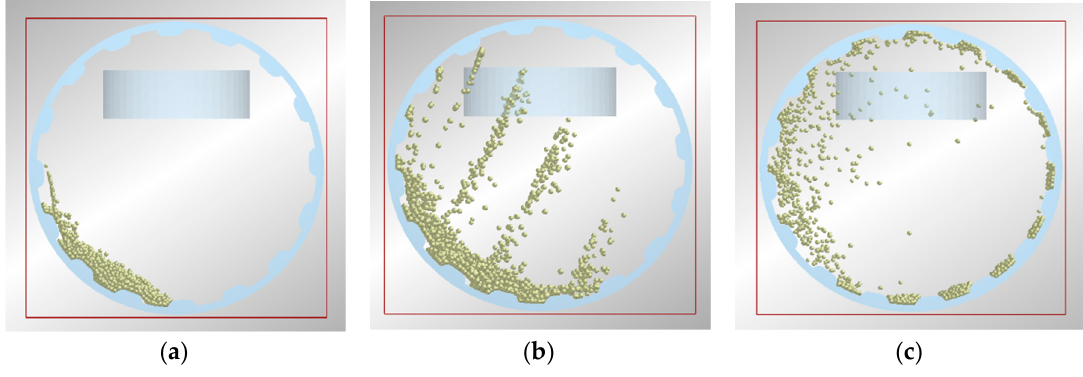
Figure 2. Three types of grinding balls: ( a ) cascading type; ( b ) throwing type; ( c ) centrifugal type.